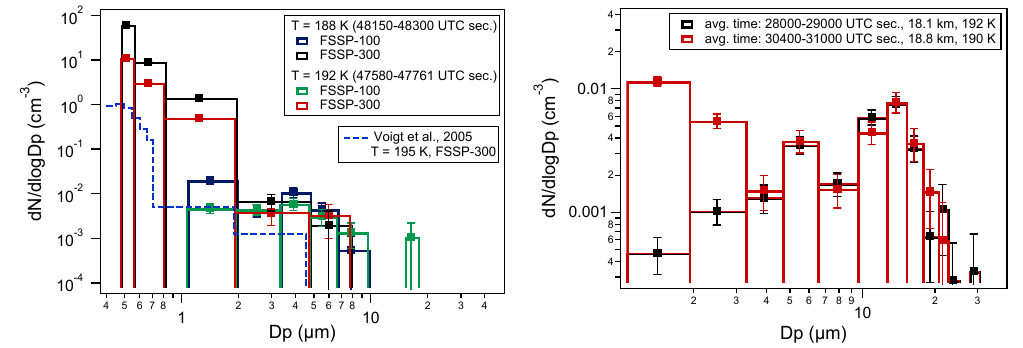
Figure 11. Size distributions of synoptic-scale Arctic PSCs as taken from successive time intervals within the same flight (left panel: 17 January 2010; right panel: 25 January 2010) but with different temperatures and altitudes. In the left panel, for comparison, a FSSP-300 size distribution from a lee-wave PSC (Voigt et al., 2005) is integrated, where atmospheric conditions of heterogeneous NAT nucleation without the preexistence of ice particles were encountered. The counting statistics are such that no error bars are visible in the graph for the smallest particles. These two panels show the NAT rock mode and the STS mode as distinguishably separate modes. In the right-hand panel the NAT size range may contain an additional, separate particle mode at size diameters D p between about 5 and 6µm.